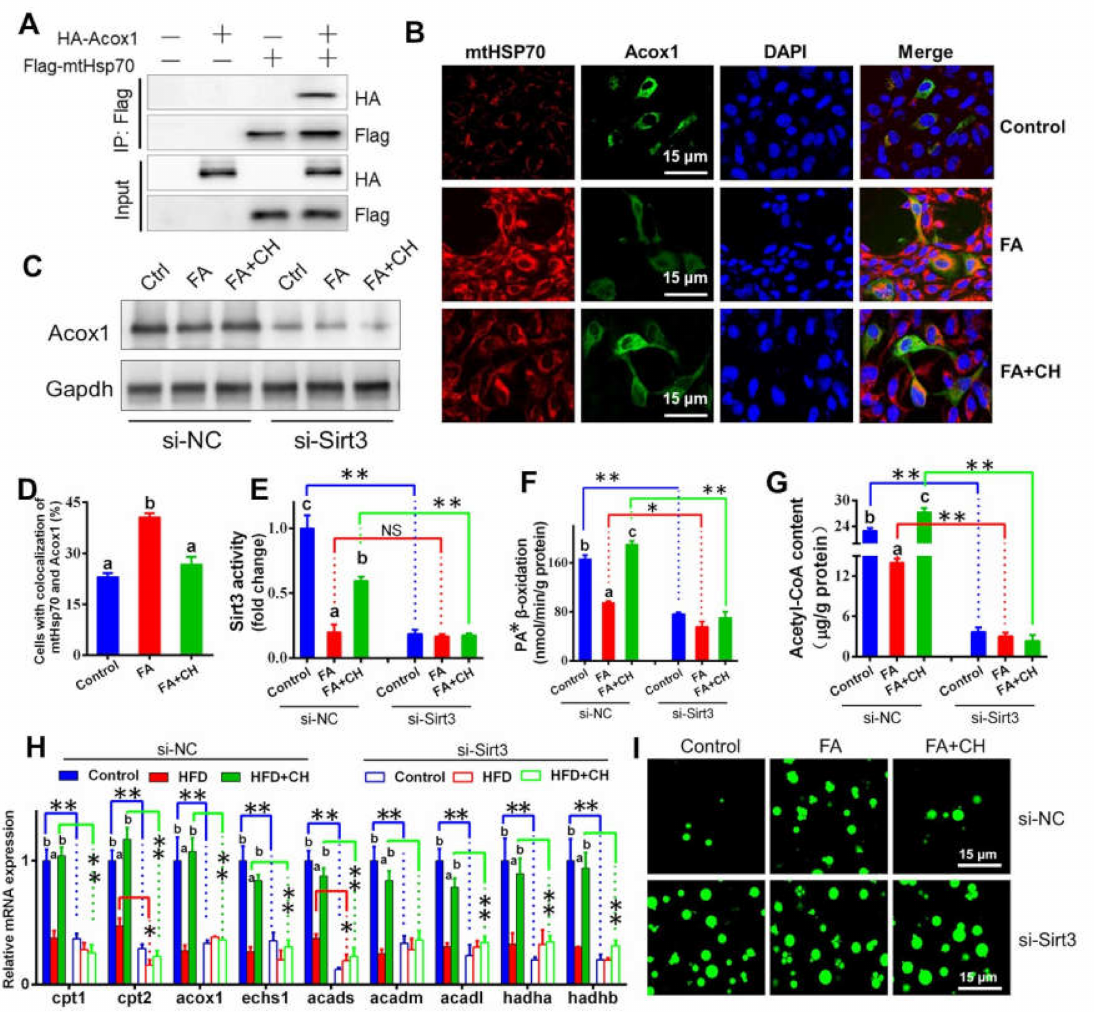
Figure 6. Choline alleviating FA-induced hepatic lipid dysregulation via SIRT3-mediated interaction between mtHSP70 and ACOX1 in the hepatocytes of yellow catfish. ( A ) Interaction of mtHSP70 with ACOX1. FLAG-tag mtHSP70 and HA-tag ACOX1 were transfected into the HepG2 cell line.